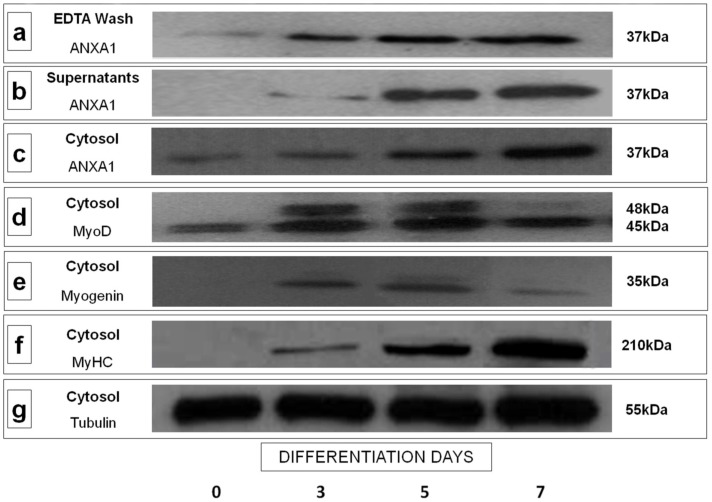
Cell surface translocation and secretion of ANXA1 during myogenic differentiation in C2C12 cells.Cell surface (a) and extracellular (b) ANXA1 from C2C12 cells in GM (0 differentiation day) and after exposure for the indicated times (3, 5, and 7 differentiation days) to DM was analyzed by Western blot with anti-ANXA1 (a, b) antibody. Total cell protein extracts were analyzed by Western blot with anti-ANXA1 (c) and with anti-MyoD (d), anti-Myogenin (e), and anti-MyHC (f) antibodies to assess myogenic differentiation rate. The protein bands were normalized on tubulin levels (g). The data are representative of 5 experiments with similar results.